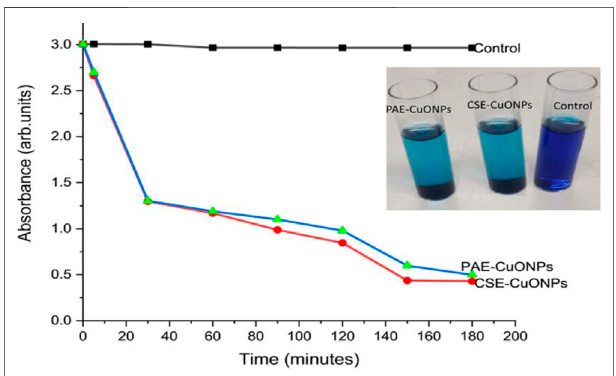
FIGURE 5 | Time-dependent photocatalytic degradation of methylene blueundersolarirradiation.Controlrepresentsmethyleneblue,CSE-CuONPs represents methylene blue treated with Camellia sinensis biosynthesized copper oxide nanoparticles, and PAE-CuONPs represents methylene blue treated with Prunus africana biosynthesized copper oxide